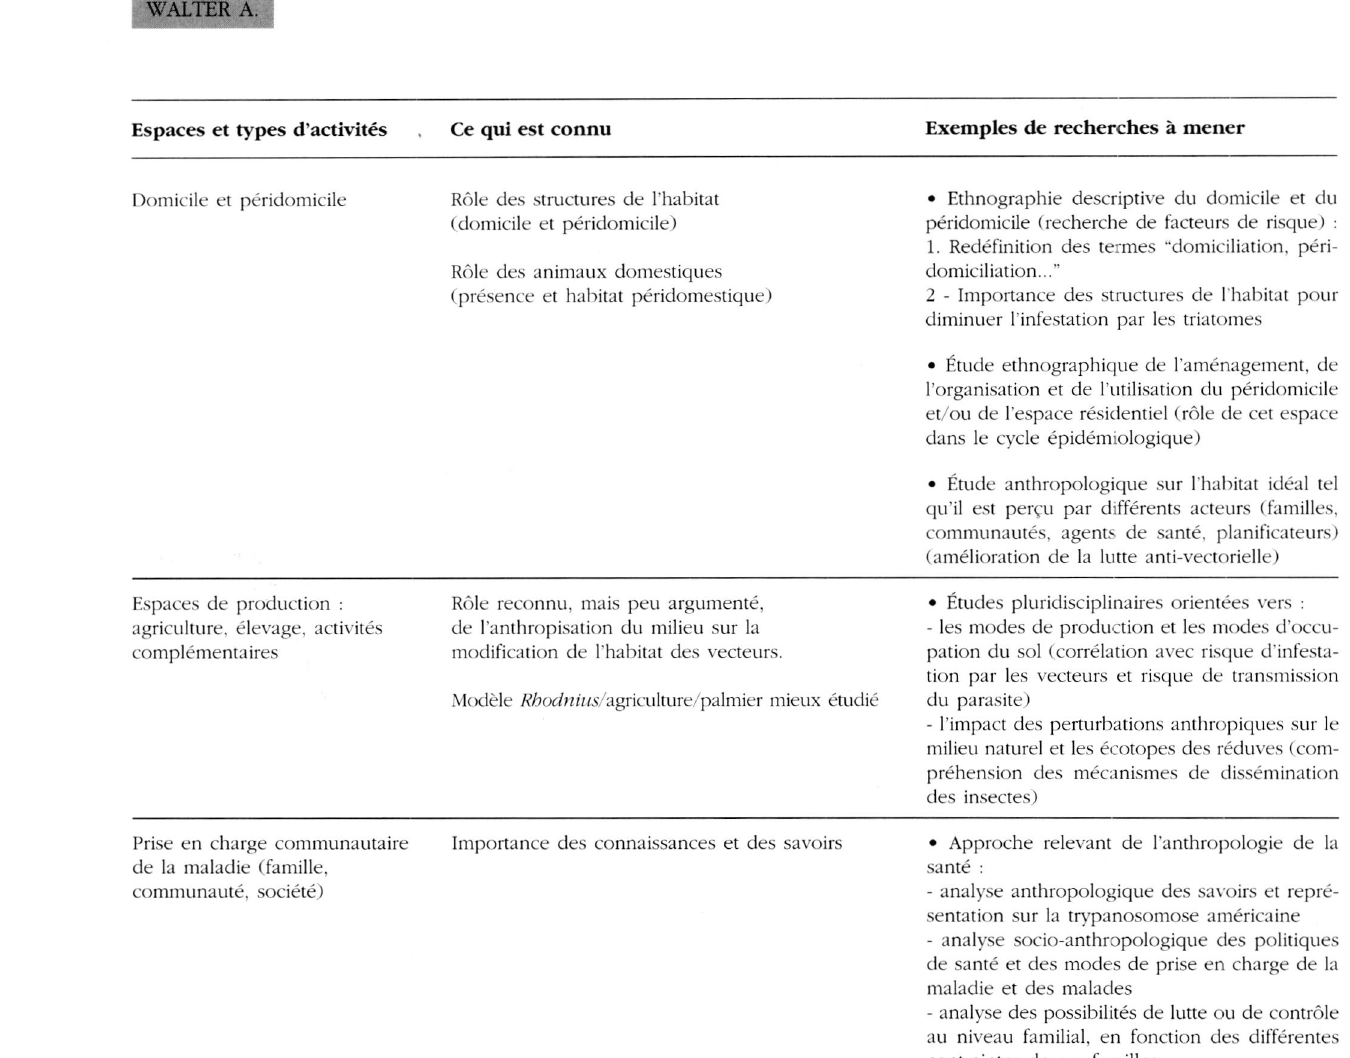
Tableau I. - Exemple d'une approche anthropologique globale de la trypanosomose